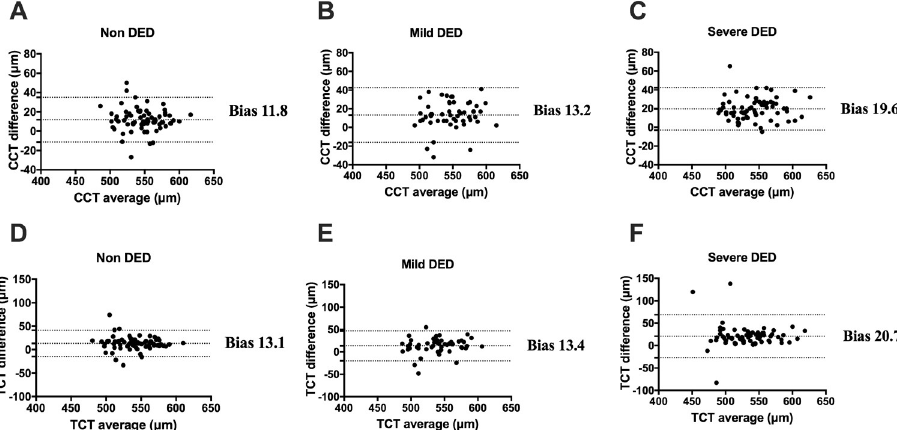
Fig 2. Bland–Altman plot for central corneal thickness and thinnest point of the cornea for Pentacam and ASOCT. The x-axis indicates the average of the thickness between the Pentacam and ASOCT measurements, and the y-axis indicates the difference between Pentacam and ASOCT (Pentacam-ASOCT). The central line indicates the mean difference (bias) between the normalized thickness from the two devices, whereas the superior and inferior lines depict the intervals that include 95.6% of all differences. ( A )–( C )show the bias for CCT and ( D )–( E )for TCT. ASOCT: anterior segment optical coherence tomography, CCT: central corneal thickness, TCT: thinnest corneal thickness.